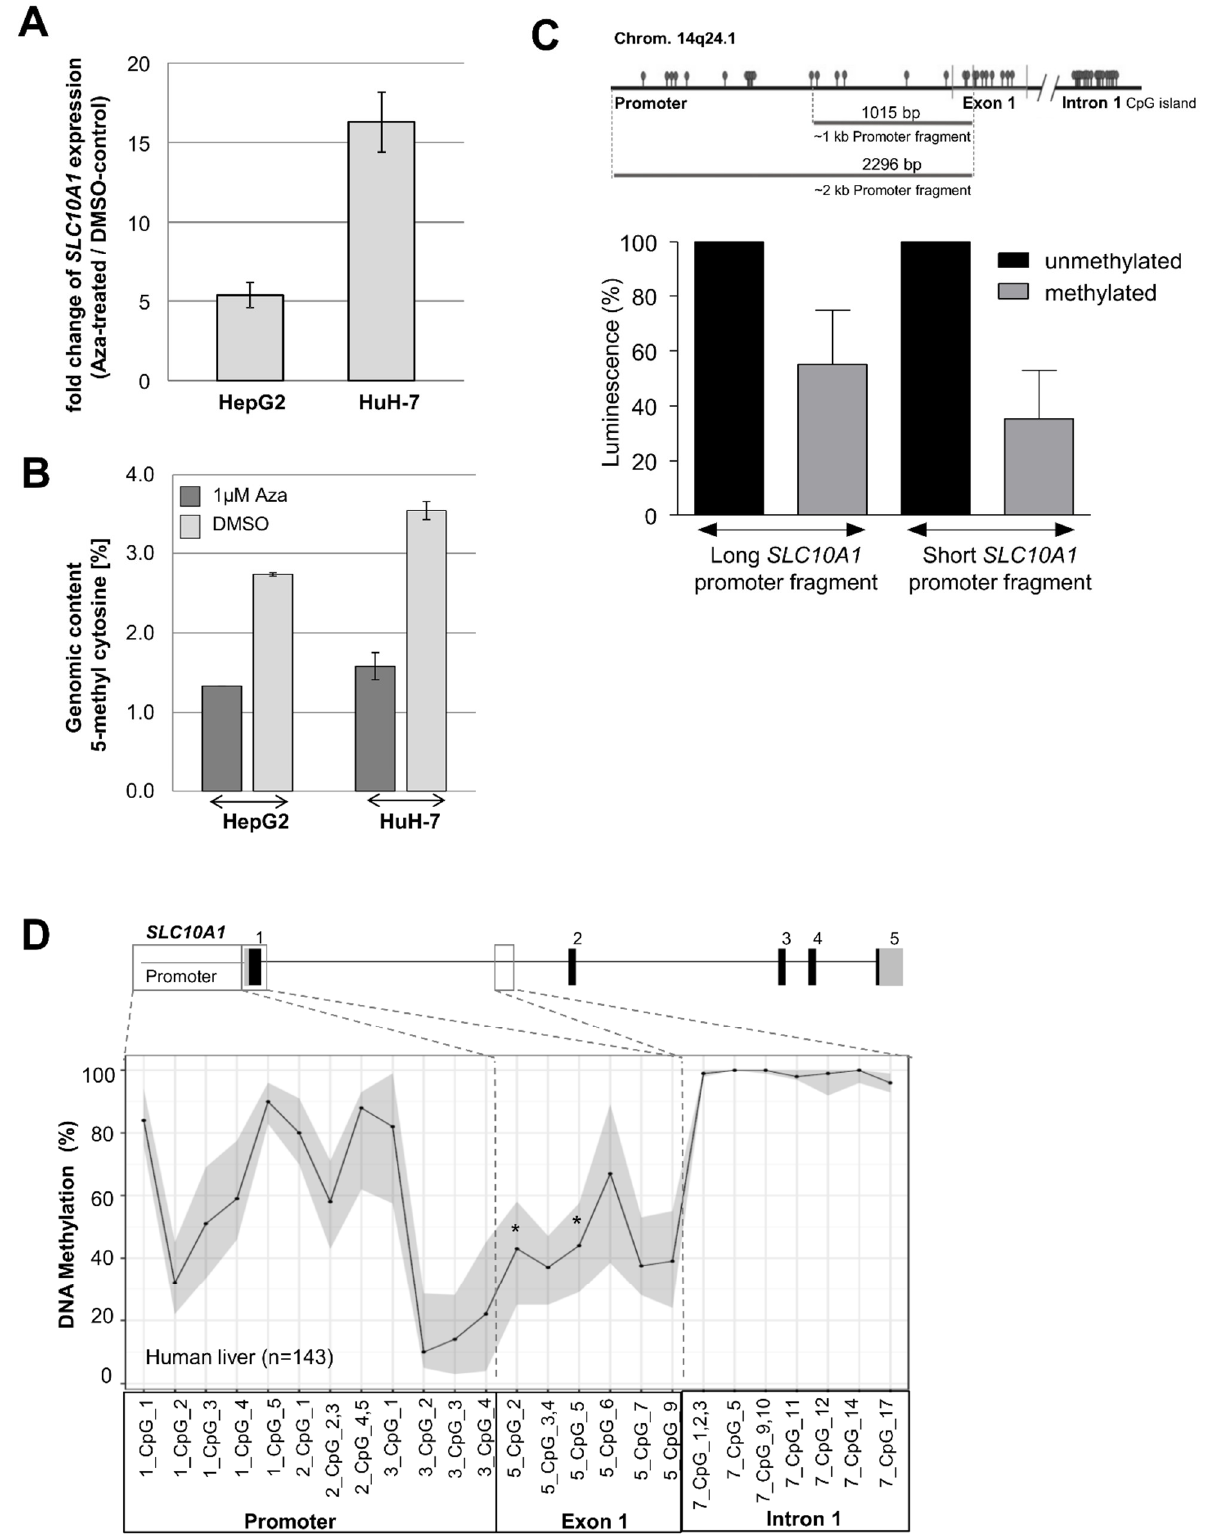
Figure 5. Epigenetic regulation of SLC10A1 /NTCP. ( A ) Effect of 5-Aza-2’-deoxycytidine (AZA) treatment on SLC10A1 mRNA expression. Cells were cultured with 1 µM AZA and mRNA levels (normalized to β -actin ) were determined using TaqMan technology. Fold increase in expression compared to untreated cells was calculated. ( B ) Effect of treatment with 5-Aza-2’-deoxycytidine on global DNA methylation. Cells were either untreated or treated with 1 µM AZA and the amount of 5-methylcytosine was quantified using LC-MS/MS to verify the effect of AZA treatment on global